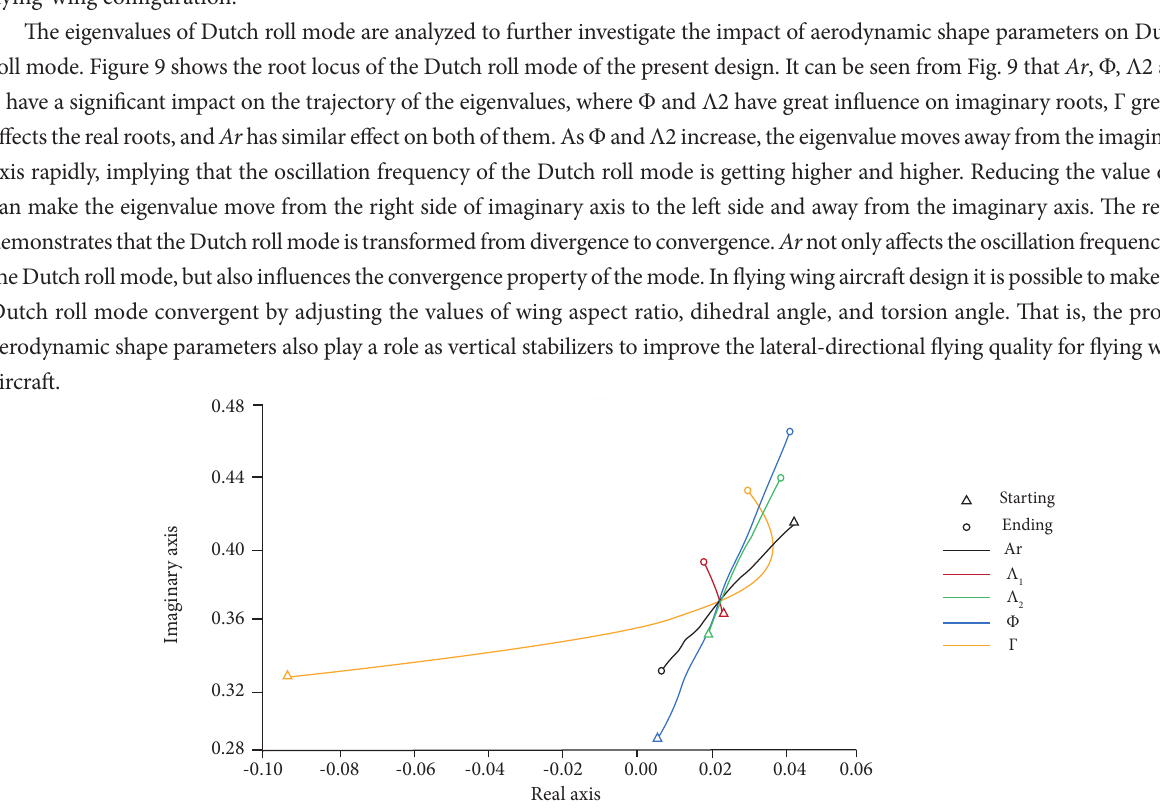
Figure 9. Root locus of the Dutch roll